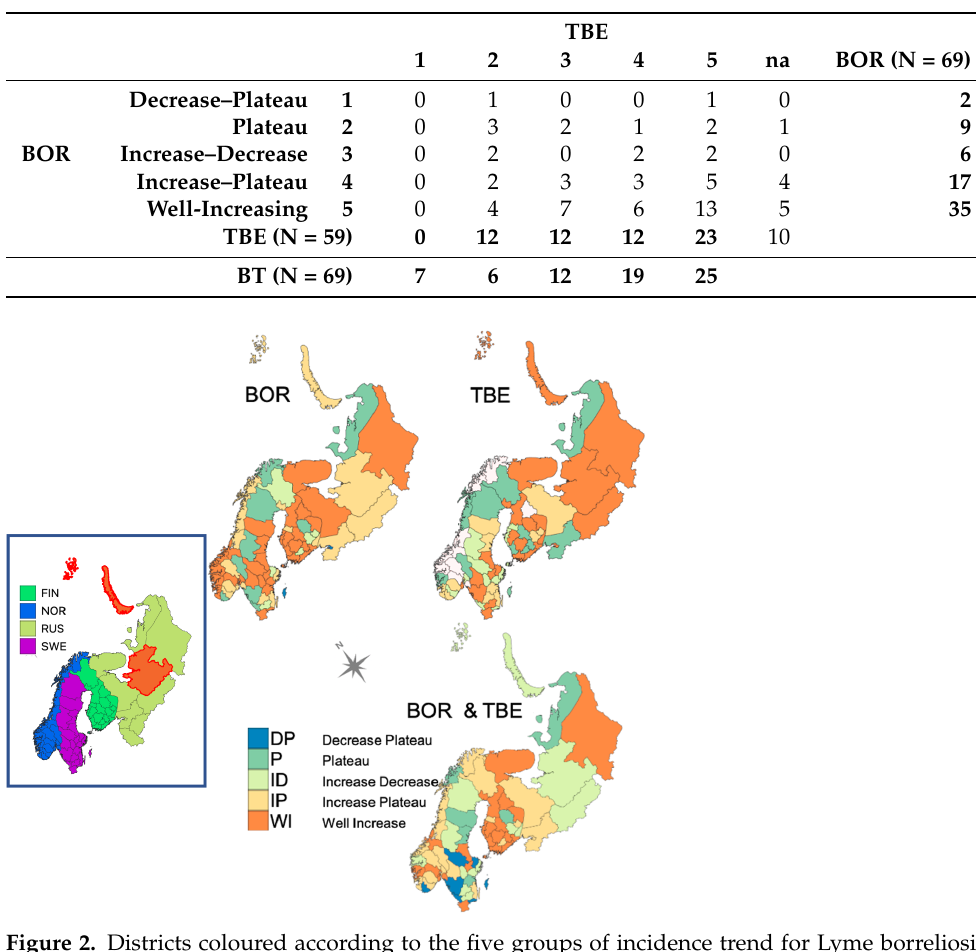
Figure 2. Districts coloured according to the five groups of incidence trend for Lyme borreliosis (BOR), tick-borne encephalitis (TBE), and their combined incidence (BT) over the 1985–2015 period ( right panel ); districts coloured according to their countries with a highlight in red for the Russian district of Arkhangelsk in three parts ( left panel